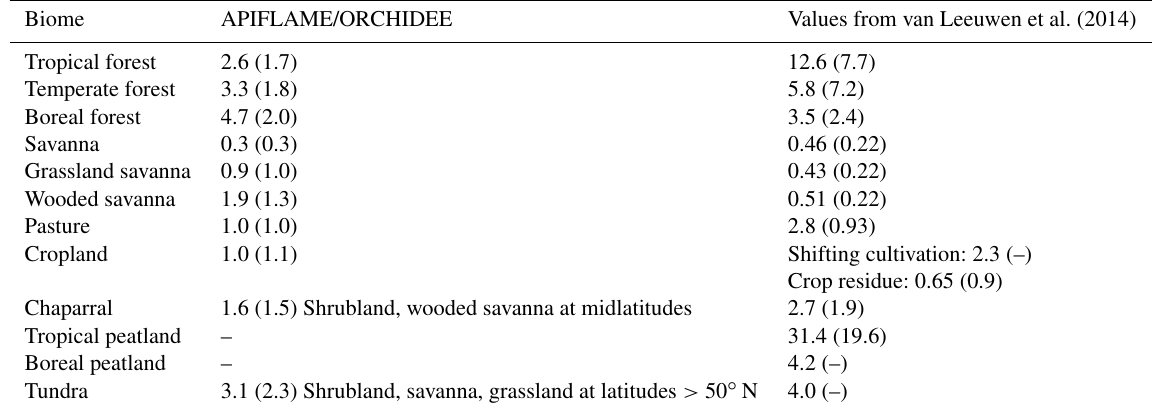
Table 1. Fuel consumption (in kilograms dry matter per square meter burned) calculated in APIFLAME from ORCHIDEE simulations (on average for fires detected in 2013–2017) and values reported in van Leeuwen et al. (2014) (used in tabulated approach). The standard deviation is provided in